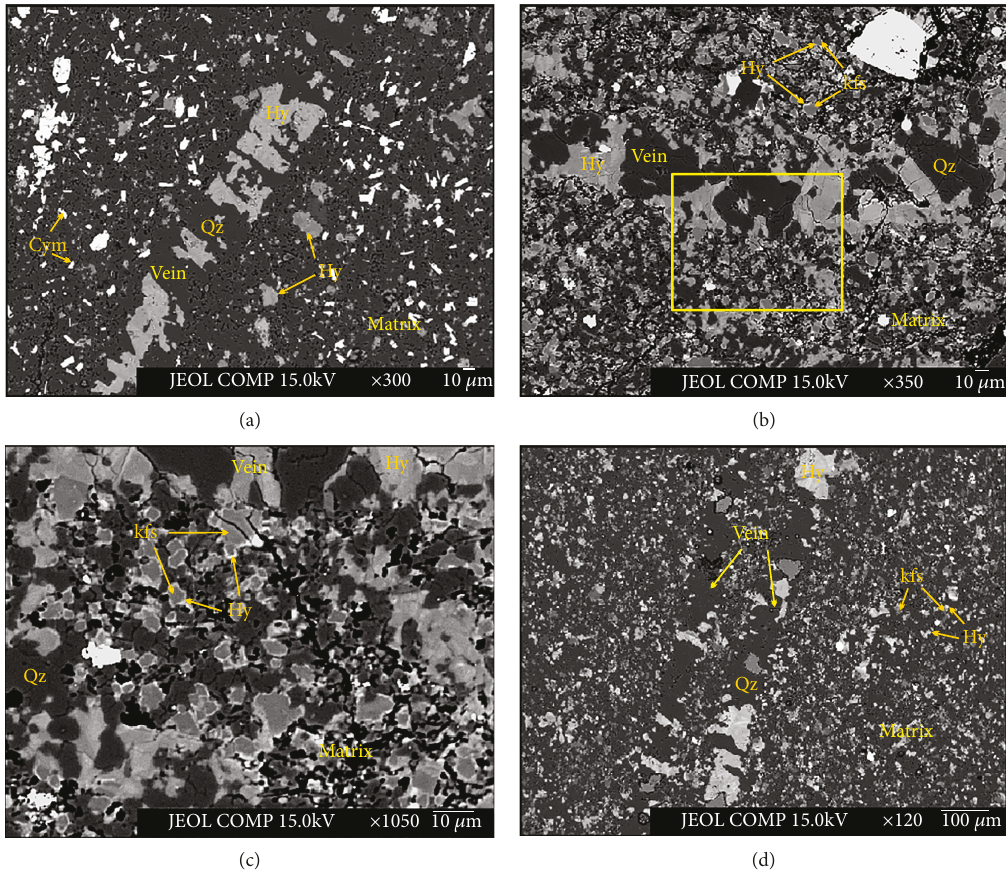
Figure 3: The occurrences of Ba-rich minerals. (a) Hyalophane grains in the vein matrix and a hydrothermal vein and cymrite in the matrix, sample WN-13. Both hyalophane and cymrite in the matrix occur as fi llings of interparticle pores. Note that some hyalophane aggregates in veins are connected to those in the matrix. (b) Hyalophane in veins and in the matrix, sample WN-19. Nearly all the clastic K-feldspar grains are surrounded by hyalophane rims. Some hyalophane aggregates in veins are connected to hyalophane rims in the matrix. (c) Closeup of the marked area in (b), sample WN-19. Hyalophane rims can be easily distinguished from clastic K-feldspar cores by the di ff erence in brightness. Hyalophane in veins and in the matrix is closely associated. (d) Hyalophane in veins and the matrix, sample WN-44. Hy: hyalophane; Cym: cymrite; Qz: